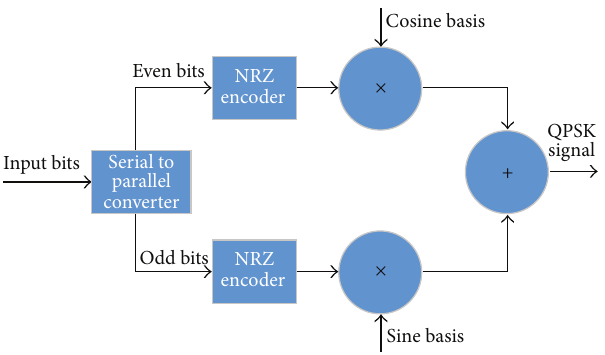
Figure 1: Passive Radar System obtains object signal information from the communication source.